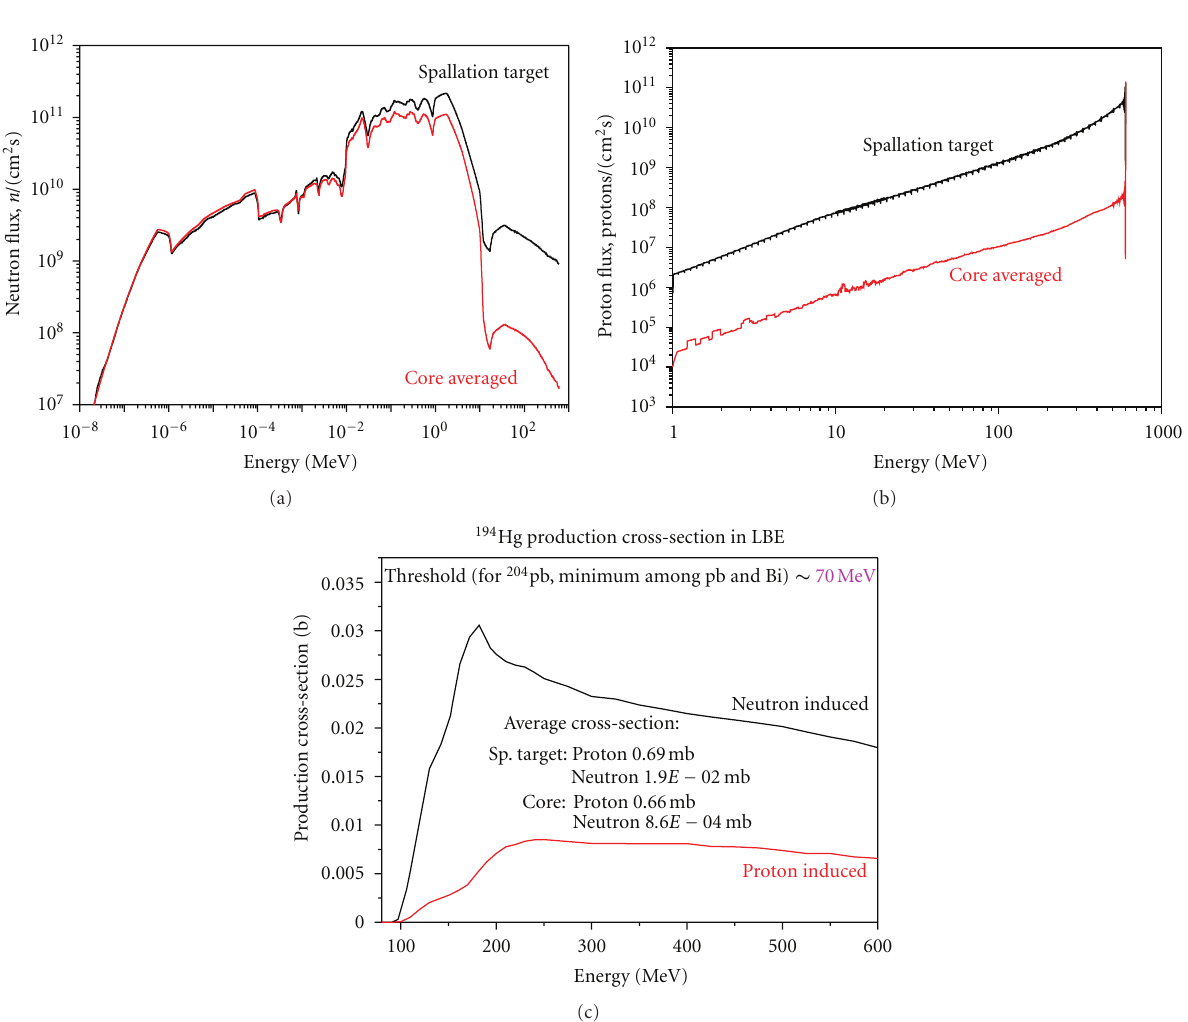
Figure 8: Neutron (a) and proton (b) energy spectra averaged over spallation target and core volumes. Neutron- and proton-induced 194 Hg production cross section from lead and bismuth isotopes (c).